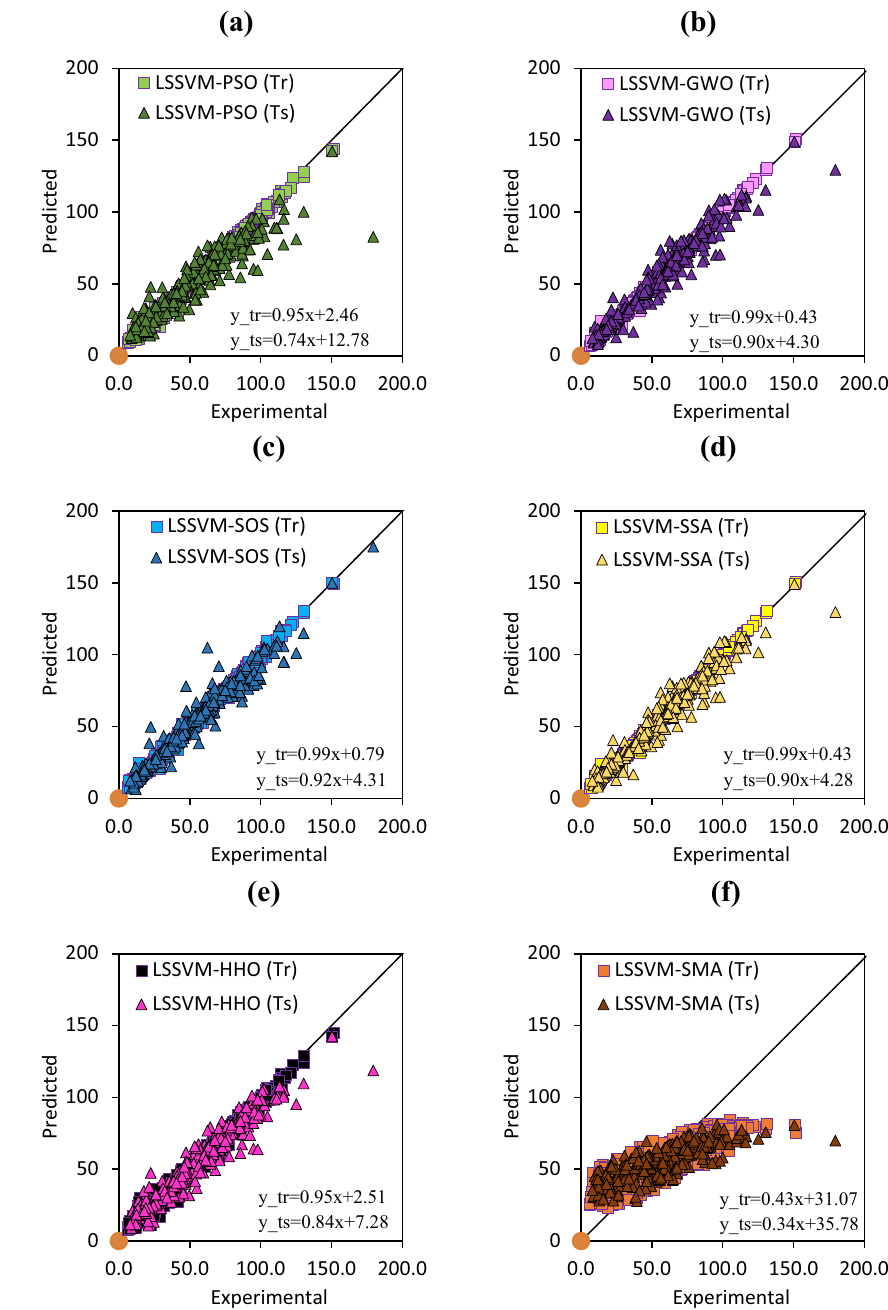
Figure 4. Proposed models, ( a ) PSO, ( b ) GWO, ( c ) SOS, ( d ) SSA, ( e ) HHO, ( f ) SMA, performances in the training (Tr) and testing (Ts)